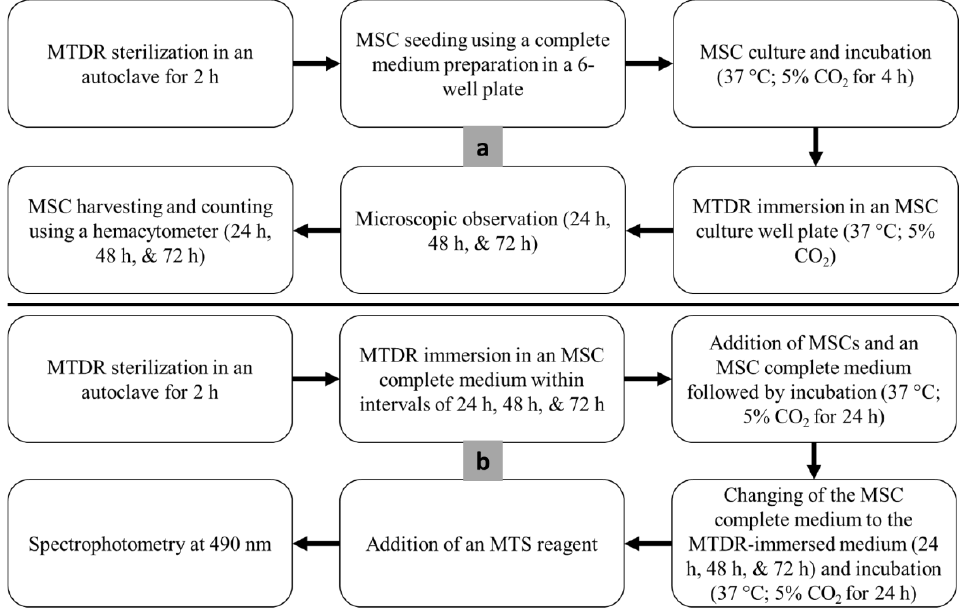
Figure 4. Flowcharts of the direct ( a ), and indirect ( b ) cytotoxicity assays.